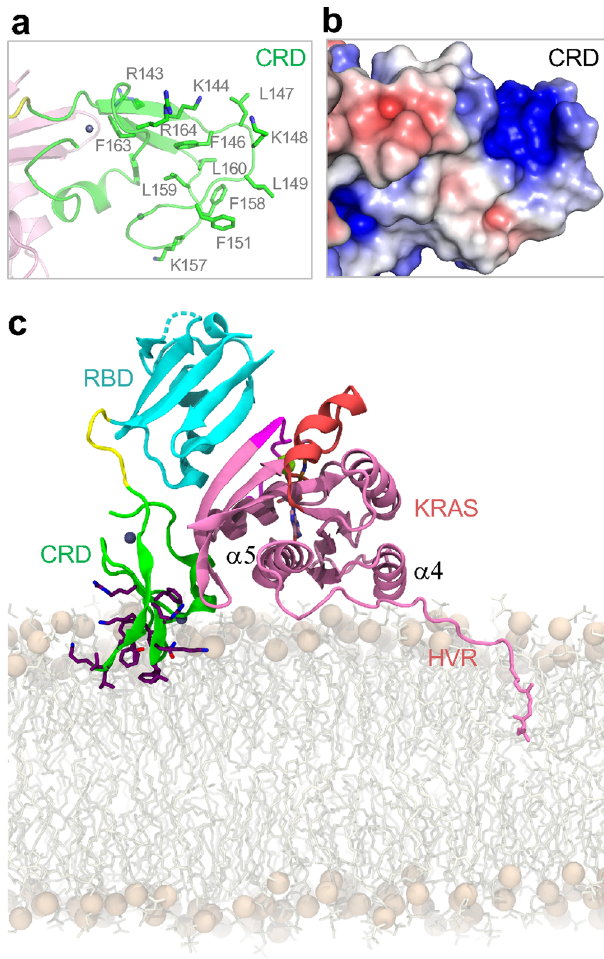
Fig. 7 Membrane interacting residues in CRD, and a model showing the crystal structure of KRAS-RBDCRD at the membrane. a Enlarged view of the CRD part of the KRAS-RBDCRD structure with CRD residues (L147, K148, L149, A150, and F158) that have been shown to interact with the PS-containing membrane shown as sticks. b Electrostatic surface representation of the CRD shown in a highlighting a basic patch which has been proposed to interact with the PS headgroups on the membrane. c Crystallographic KRAS-RBDCRD oriented with KRAS helices α 4 and α 5 in membrane contact, as observed in MD simulations of KRAS 28 . Lipids are sticks with spheres for headgroup phosphorus atoms; KRAS-RBDCRD has the same color-coding de fi ned in Fig. 1c. Side chains of CRD residues 143 RKTFLKLAF 151 and 157 KFLLNGFR 164 are sticks with purple carbon